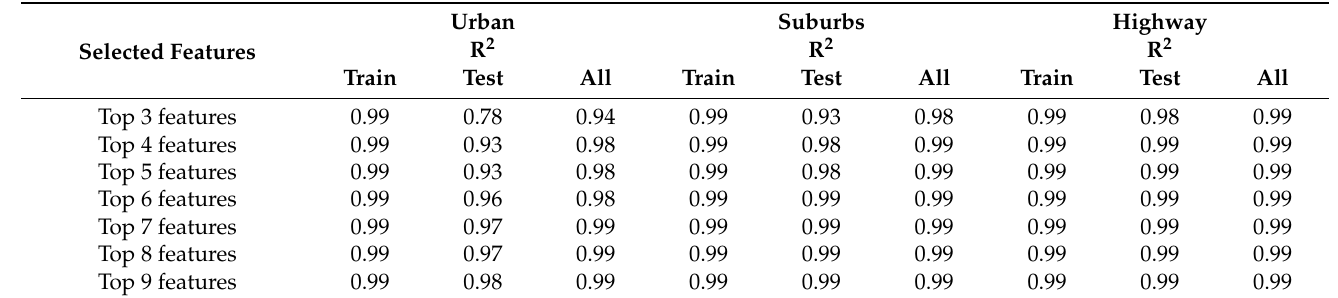
Table 9. Performance R 2 statistics results of NO x model.